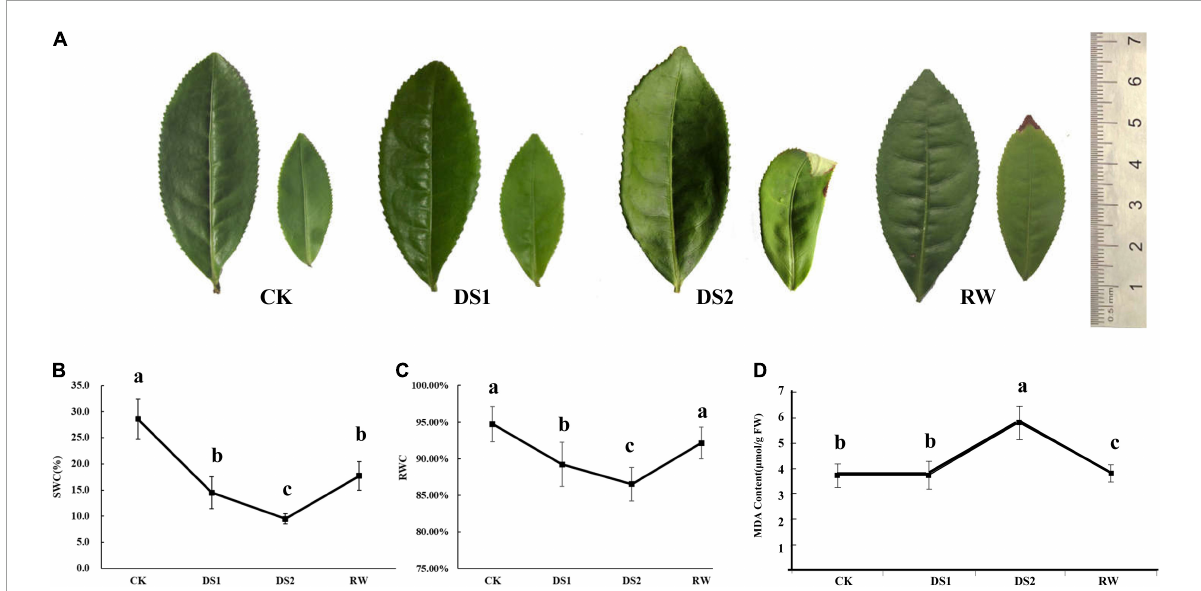
FIGURE1 Phenotypic changes of mature and tender tea leaves (A) , the water content of the soil (B) , the relative water contents (C) and MDA contents (D) of tea leaves from tea seedlings under drought and re-water conditions.